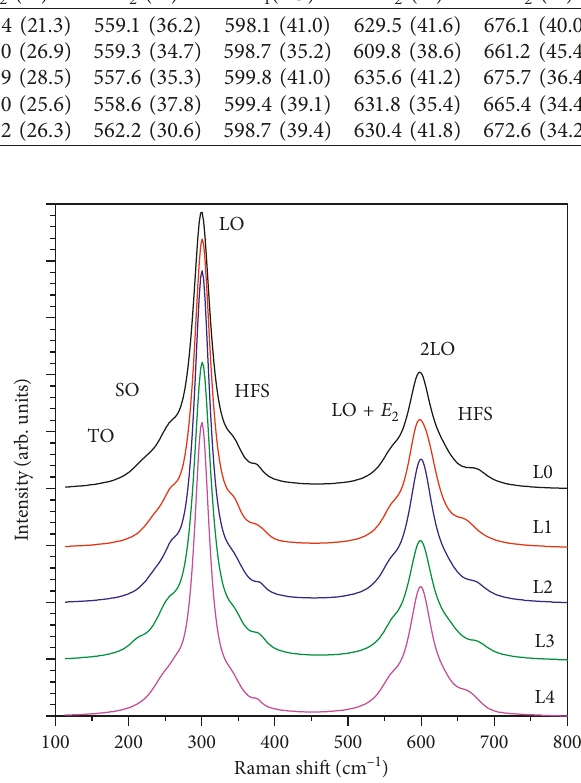
Table 2: Summary of centers and FWHM (in parentheses) for the different optical vibrational modes observed in all set Raman spectra. Fundamental optical phonon First overtone Sample